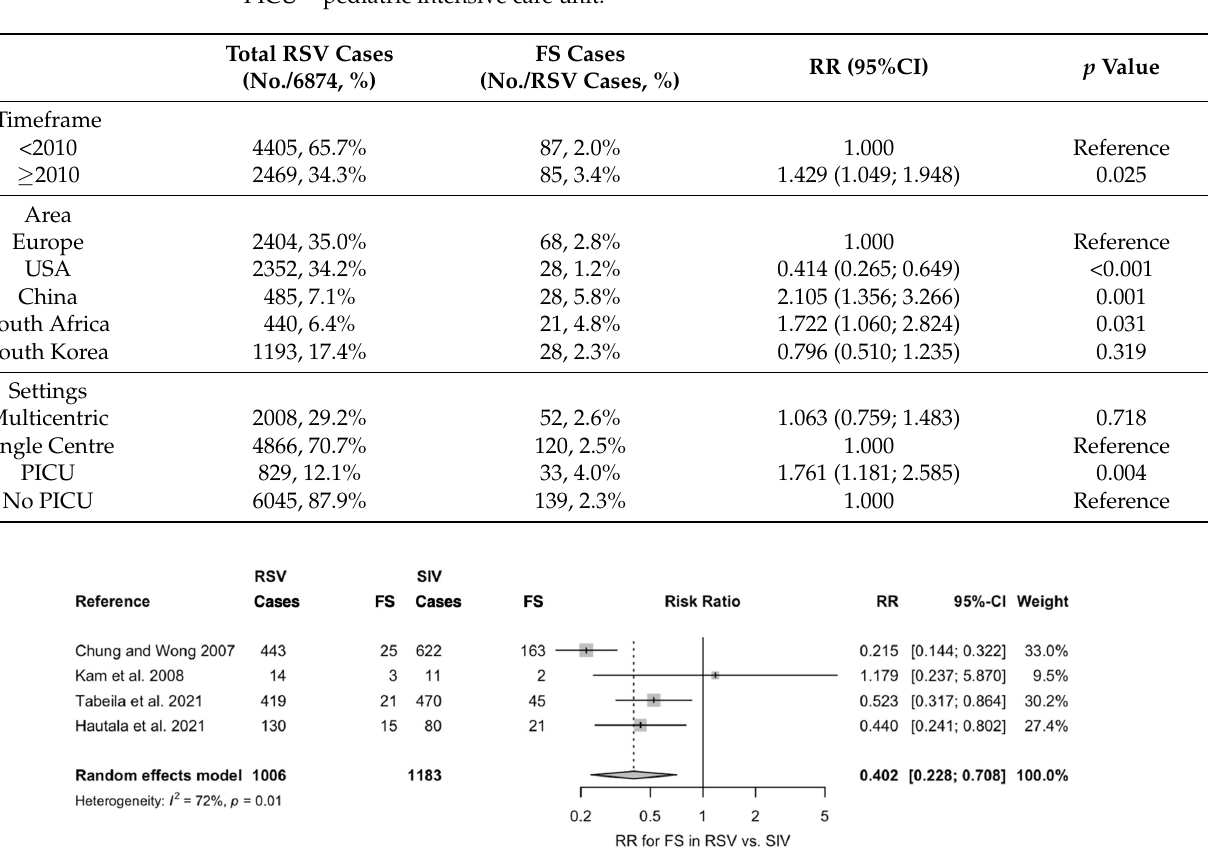
Table 5. Occurrence of febrile seizures (FS) in the collected studies reporting on cases of Respira-